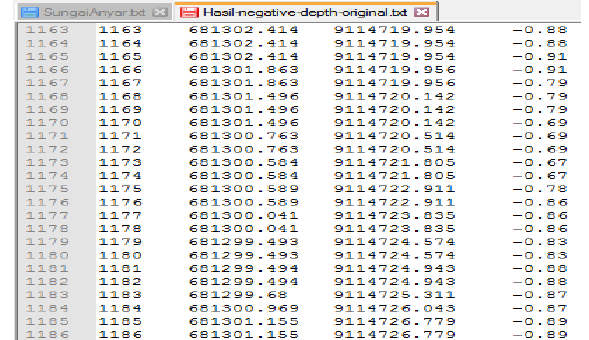
Figure 13. Before correction (-ve signed elevation - depth).